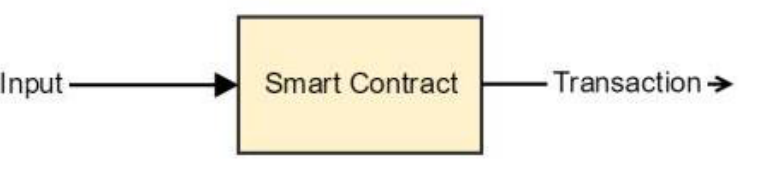
Figure 1. A program executing by smart contract (takes input and produces matching)